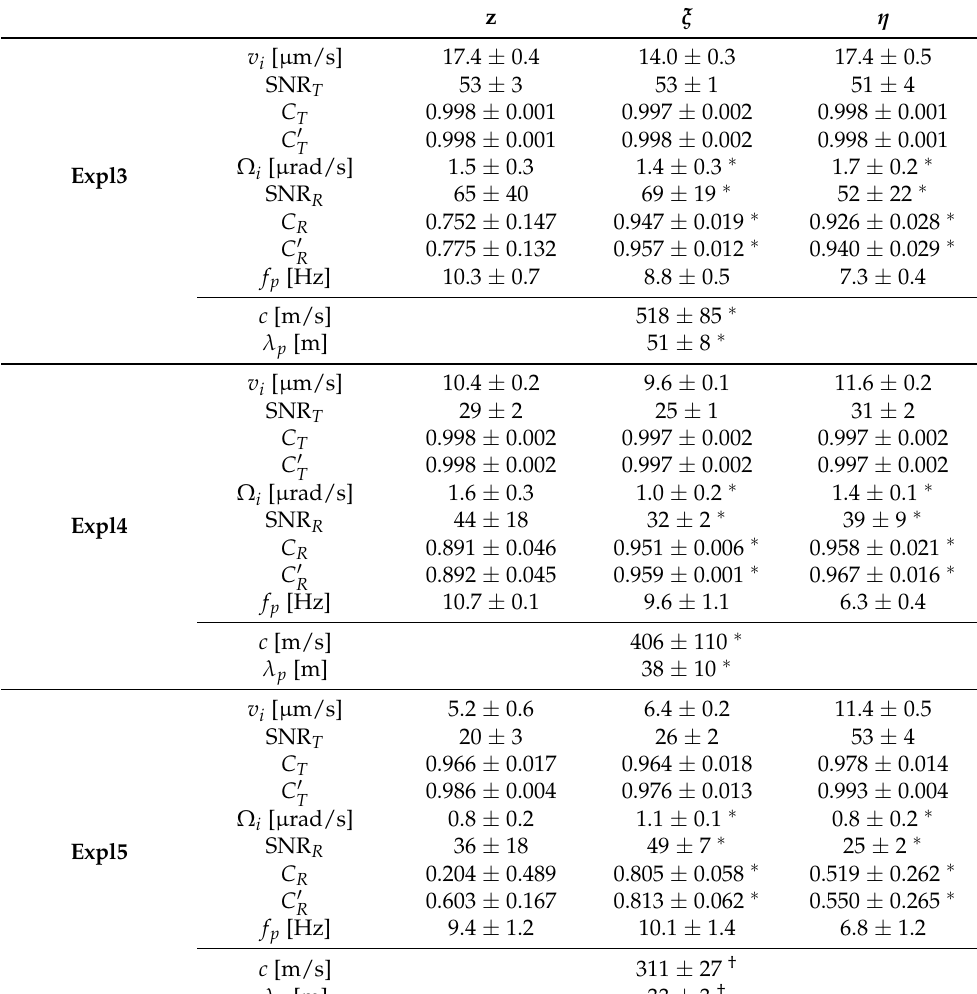
Table 4. Field active-source Rotaphone measurements by component ( z —vertical, ξ —radial, η — transverse): means over Rotaphones ± standard deviation. Key: see caption of Table 3; C (cid:48) maxims of correlation function between Rotaphone